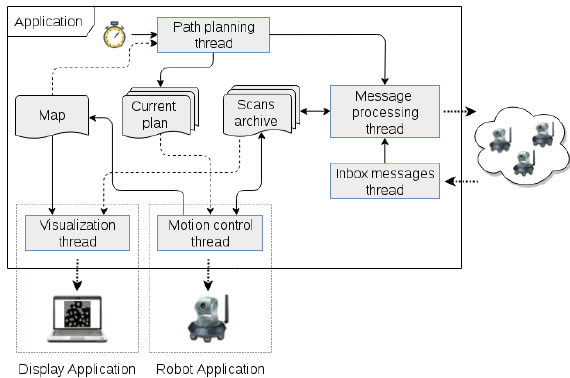
Figure 1. Proposed application